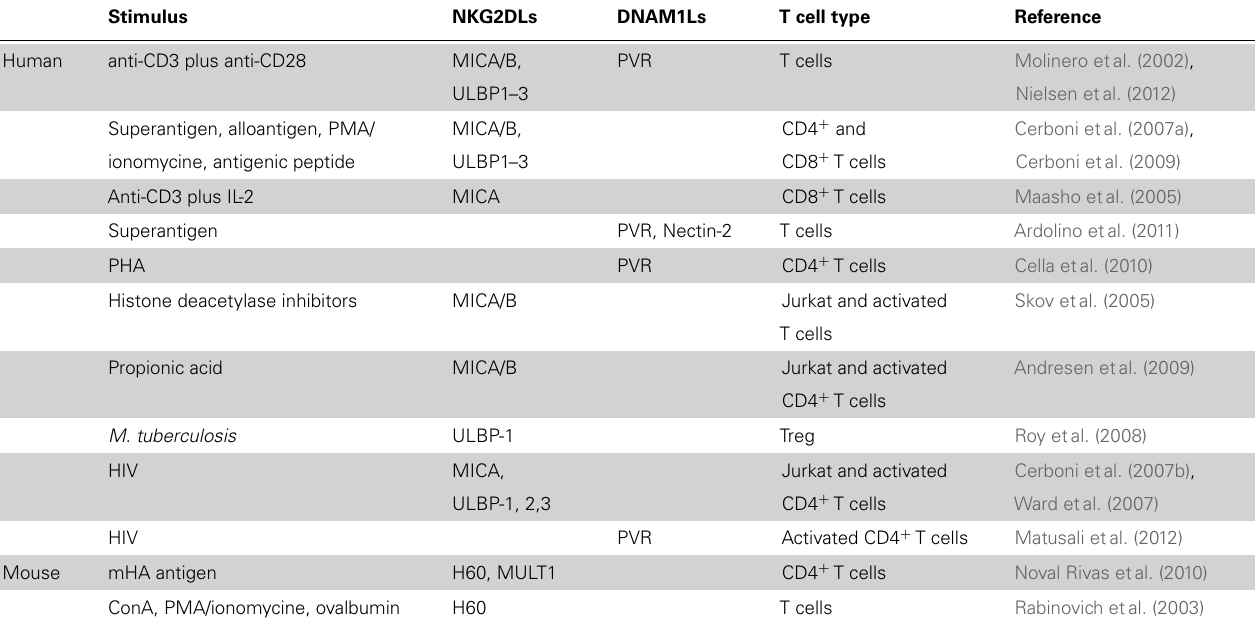
Table 1 | Different stimuli implicated in the induction or up-regulation of NKG2D and DNAM-1 ligands on activatedT